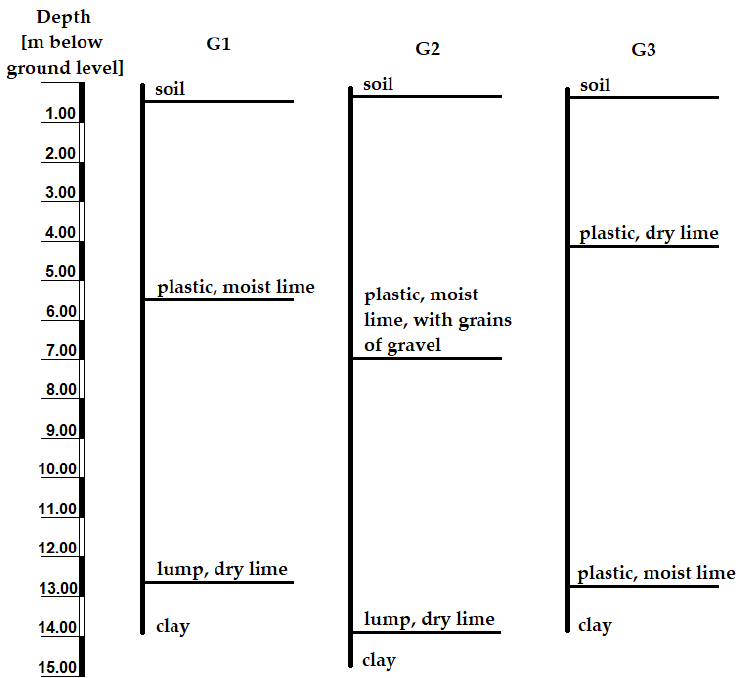
Figure 3. Soil profiles of points G1–G3. Source: own study .